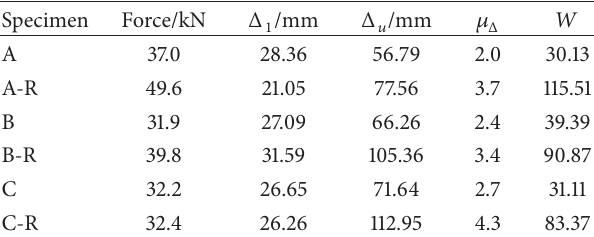
Figure 4: Loading history.